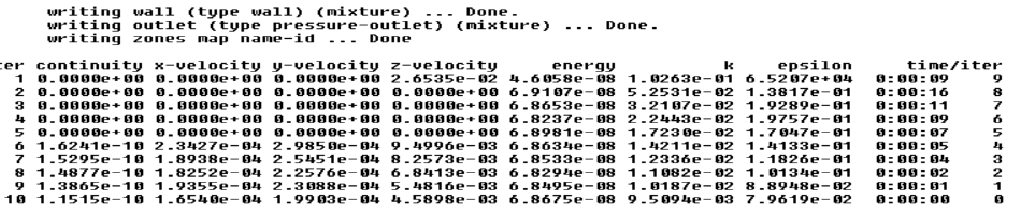
Fig. 4: First five zero iterations from total iterations